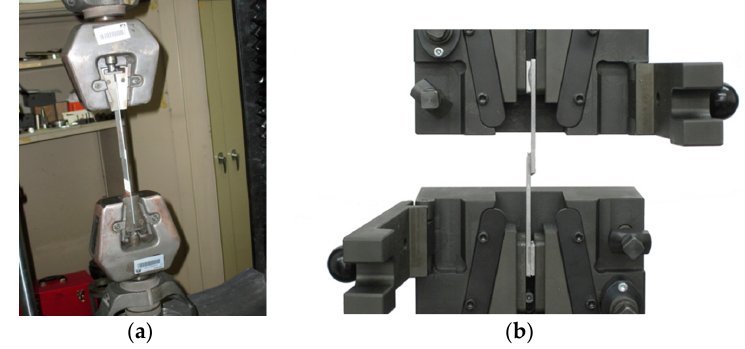
Figure 21. ( a ) Photograph of grips employed and set up of the Instron model 1125; ( b ) Cross section of the supplier’s grips .